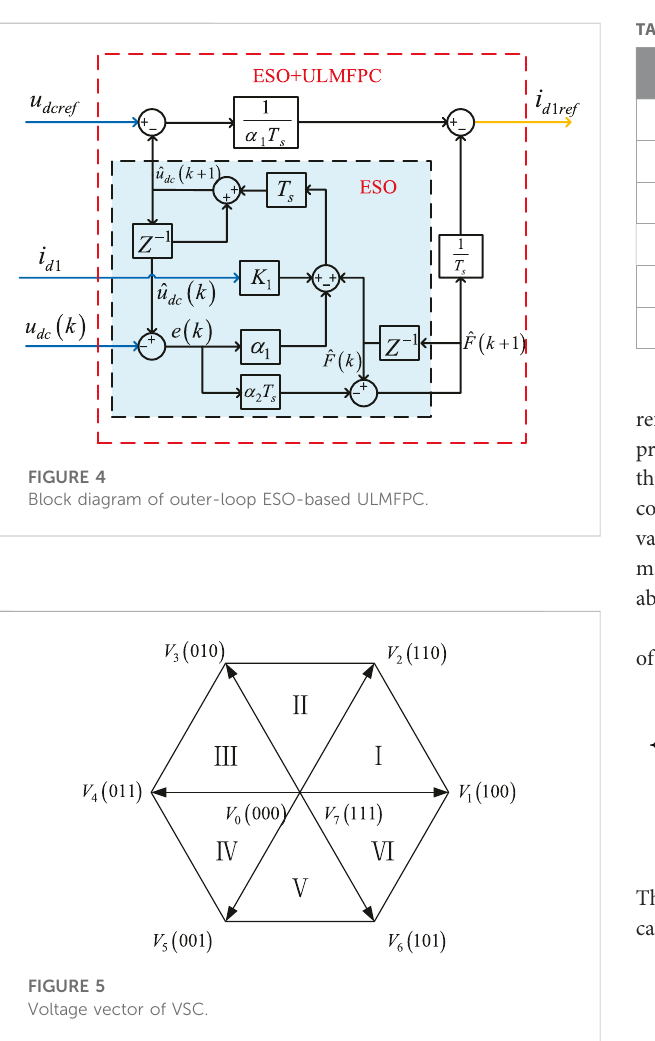
Figure 4 shows the block diagram of outer-loop ESO-based ULMFPC.